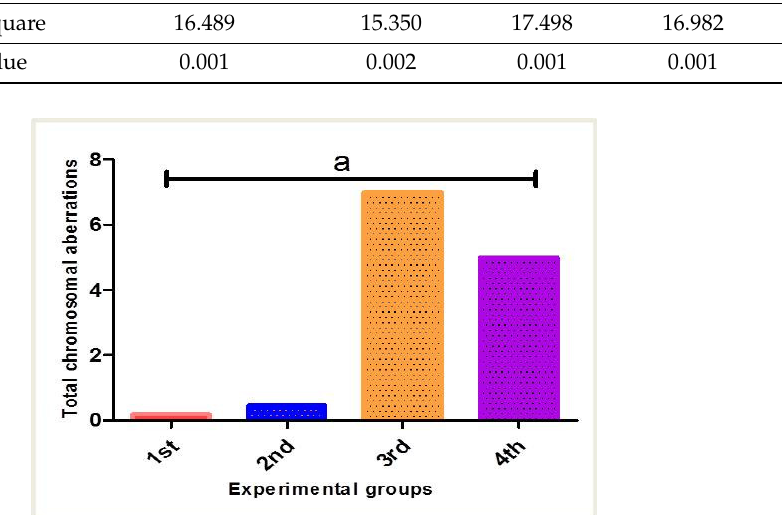
Figure 9. Total chromosomal abnormalities for different experimental groups. The first group is controlled mice (red column), the second group is PPE-treated mice (blue column), the third group is Fe 2 O 3 -NPs-exposed mice (orange column), and the fourth group is Fe 2 O 3 -NPs plus PPE-treated mice (purple column). The different letters (a, b, c) are different levels of significance ( p < 0.05). The “a” letter indicates high significance, the “b” letter indicates significance, and the “c” letter indicates non-significance.